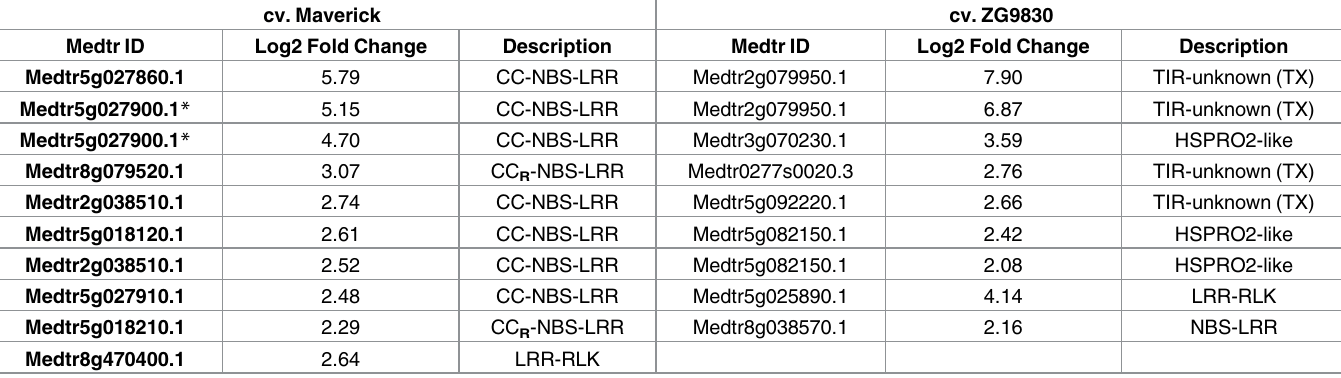
Table 4. Candidate genes involved in the resistance response against PssALF3 in two alfalfa cultivars. cv.